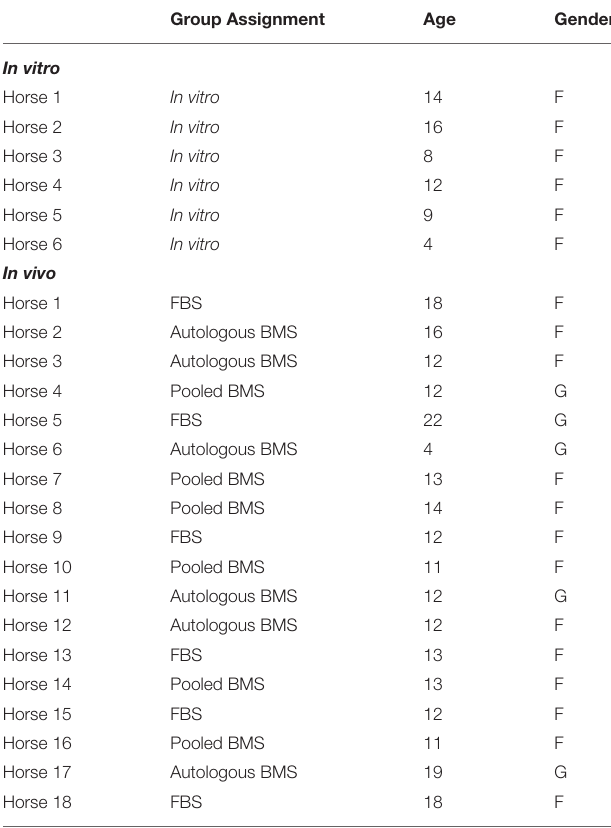
TABLE 1 | Age, and gender (F = female; G = gelding, castrated male) of horses in both the in vitro and in vivo